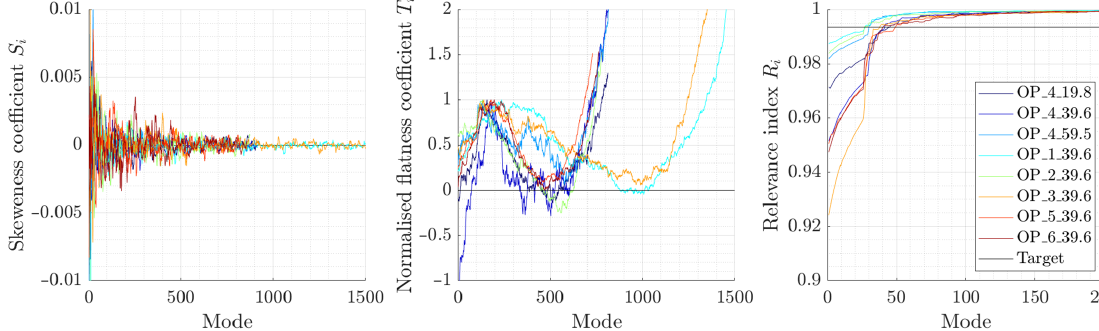
Figure 16. Skewness, normalised flatness coefficients, and relevance index for POD quadruple decomposition of all the operating points using PIV data. Table 3. Three cut-off modes of the POD quadruple decomposition for all the operating points measured using PIV. OP